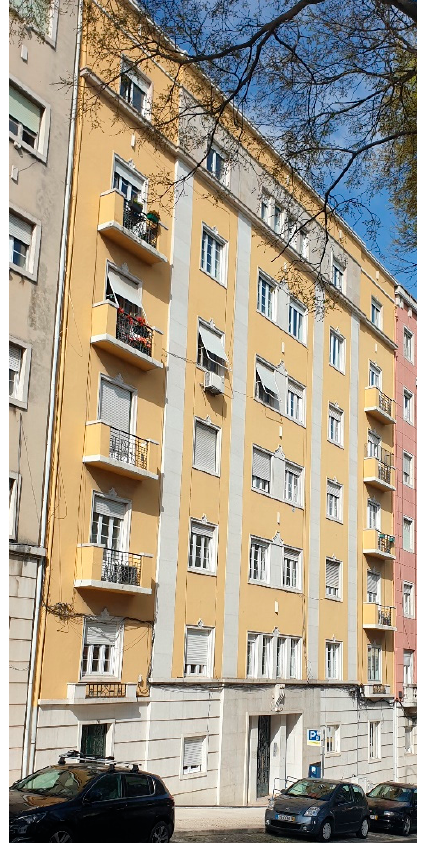
Figure 1. Exterior view of a “Placa” building in Lisbon, Portugal.